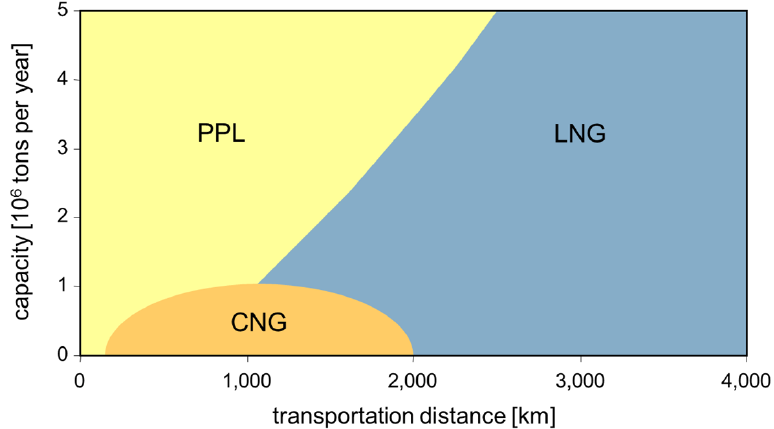
Figure 11. Economic comparison of natural gas transportation technologies in a